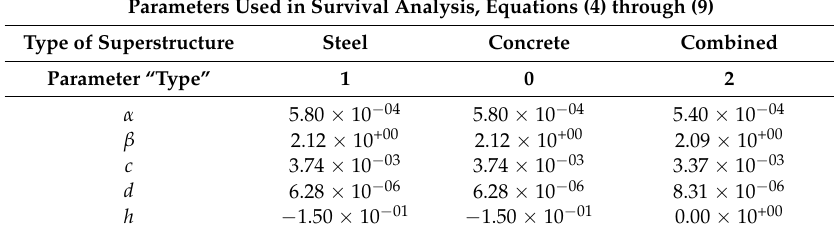
Table 4. Reliability and failure rate parameters.